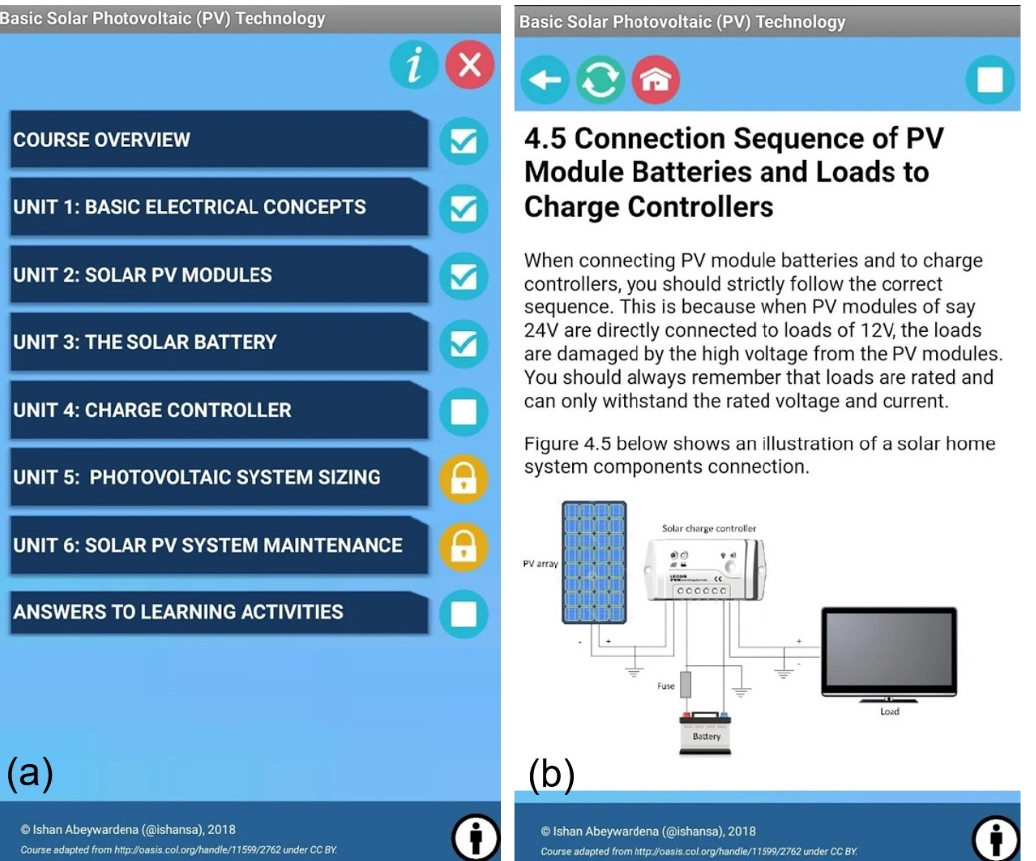
Figure 7. Representative smartphone application (Solar PV Technology Mobile Course) for education and learning purposes related to PV systems: ( a ) outline of educational course, ( b ) educational material.